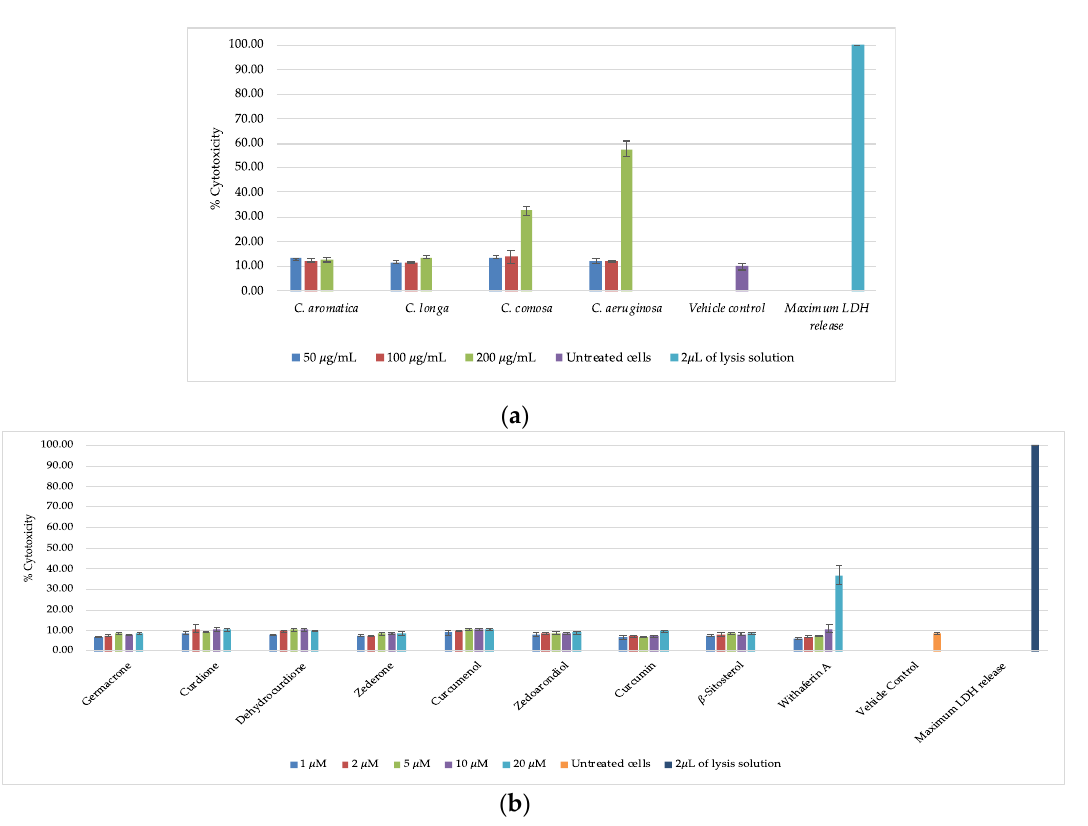
Figure 4. Disruption of membrane integrity measured by the release of lactate dehydrogenase (LDH) (CytoTox- ONE™). ( a ) Relative cytotoxicity (%) of four Curcuma species in HaCaT cells. ( b ) Relative cytotoxicity (%) of pure compounds isolated from C. aromatica and the reference cytotoxic anti-cancer compound withaferin A in HaCaT cells.